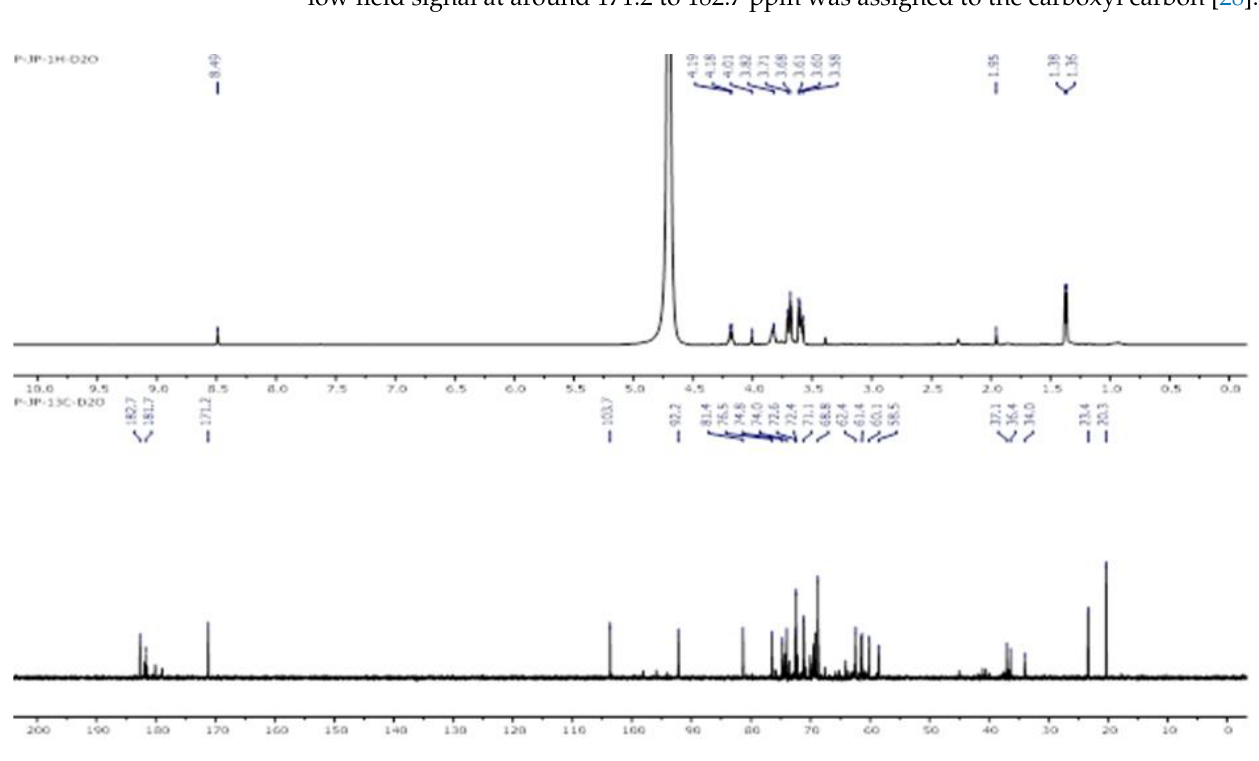
13 C NMR spectra (D 2 O, 500 MHz) and 2 O, 125 MHz) of